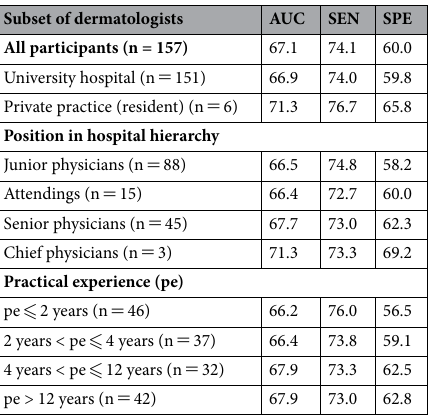
Table 4. Diagnostic performance of 157 dermatologists by MClass-D